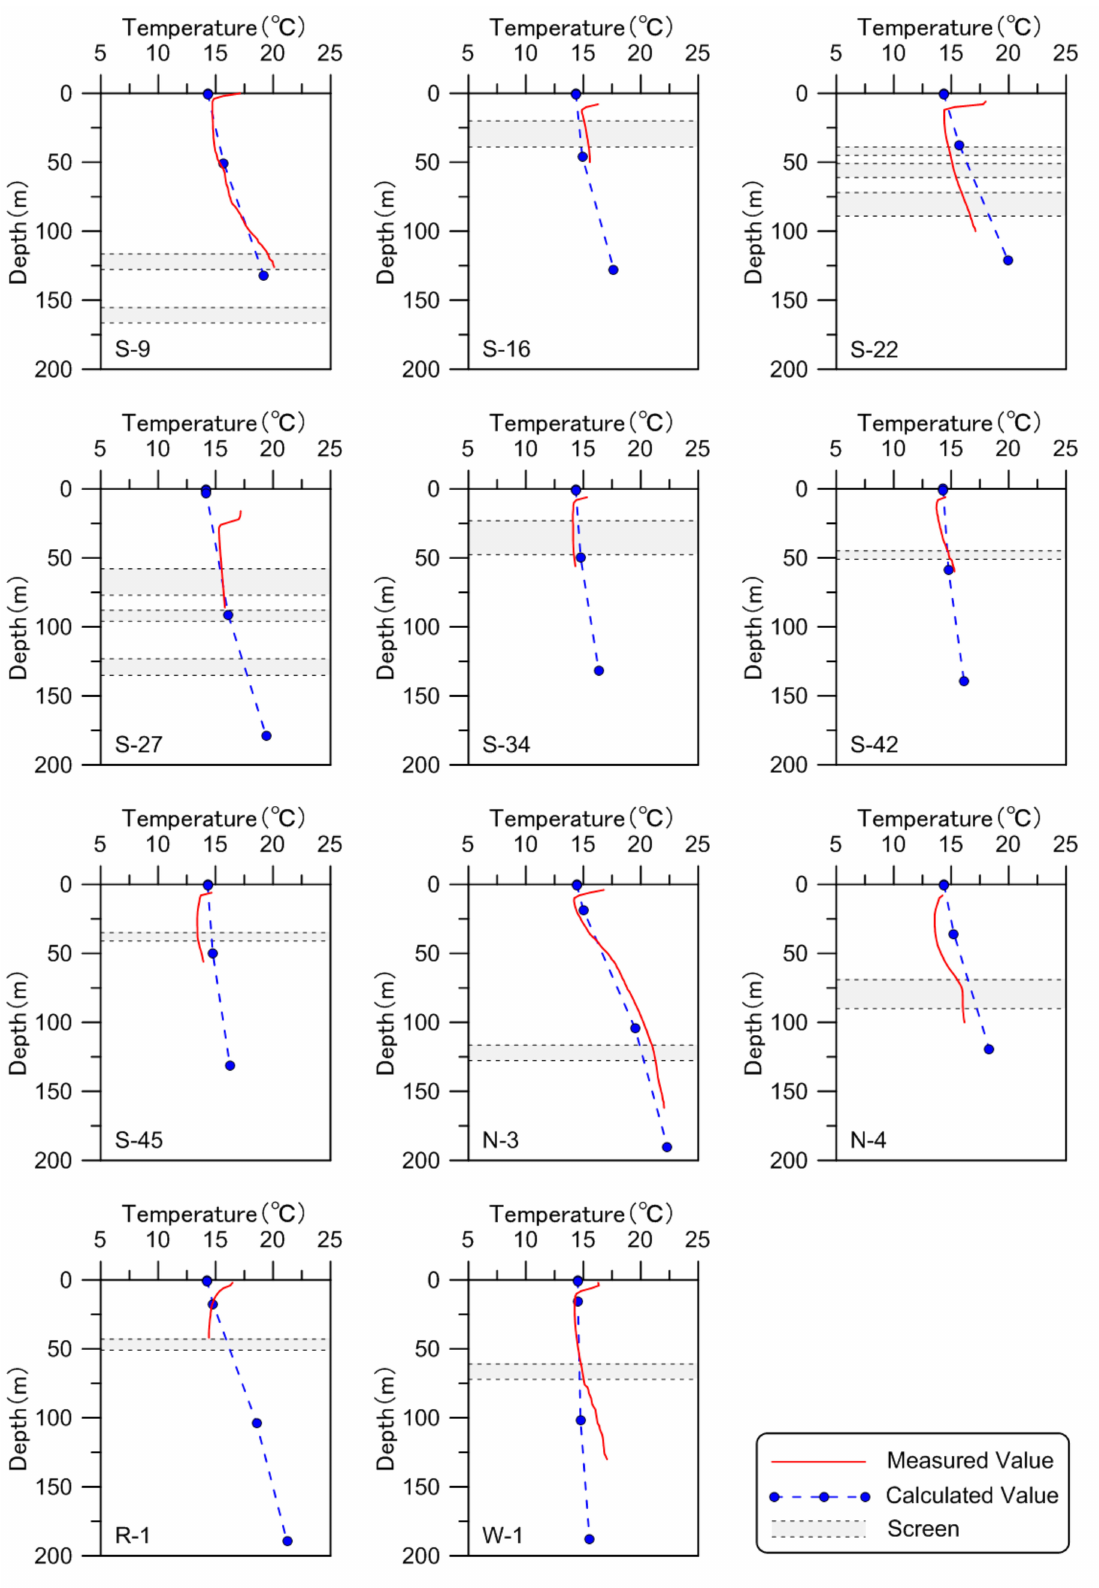
Figure 5. Comparison of measured subsurface temperature profiles with calculated